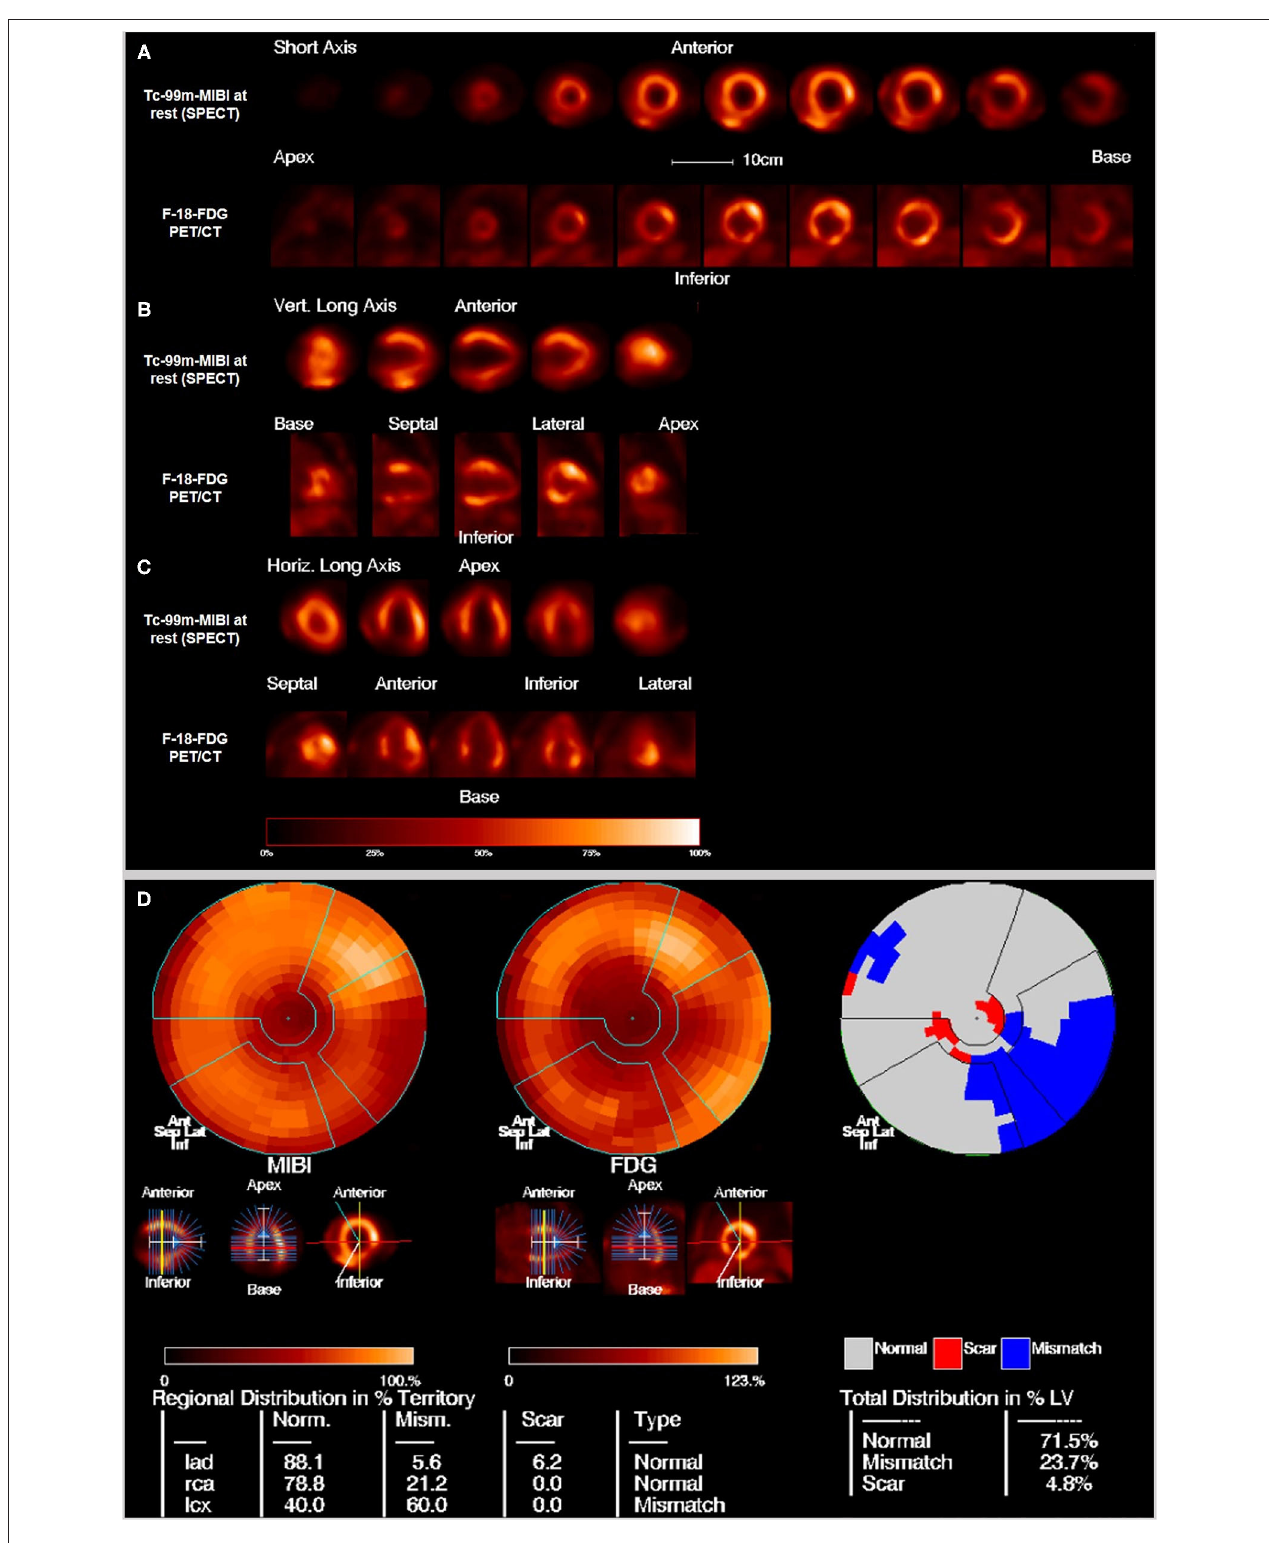
FIGURE 1 | Example of hibernating myocardium: 76 years old male with a perfusion defect on the posterolateral wall in the Tc-99m-MIBI rest scan that shows FDG uptake in the viability F-18-FDG-PET/CT scan resulting in the diagnosis of hibernating myocardium. (A) Short axis, (B) vertical long axis, and (C) horizontal long axis. The upper rows show the perfusion scan at rest with Tc-99m-MIBI (SPECT), the lower rows show the viability scan with F-18-FDG (PET). (D) Polar maps and subtraction image to visualize the mismatch between the perfusion defect on SPECT and the viability on FDG-PET/CT. 23.7% of the myocardium in the left ventricle is in hibernating